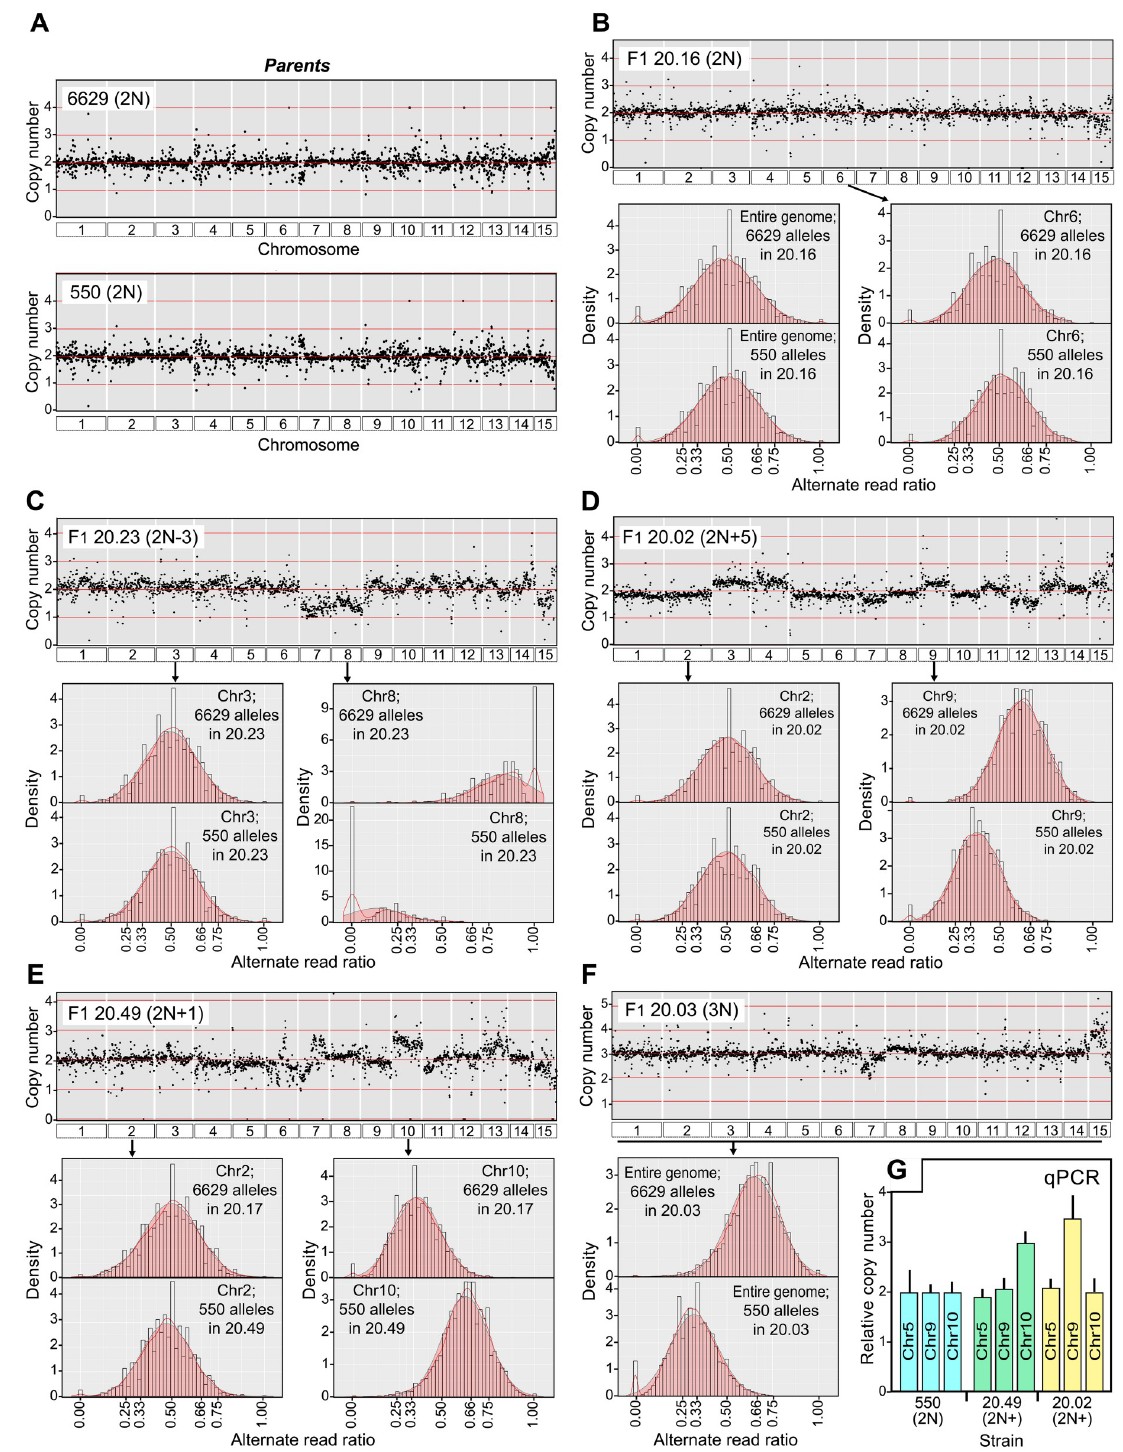
Fig 5. Chromosomal content of representative strains. A , Normalized Illumina read depth across all chromosomes in parents 6629 and 550. B , A representative diploid F1 (20.16) from the 6629 × 550 cross. Plotted in the scatterplot at the top is the normalized read depth. Presented below are bar graphs showing the alternate read ratios (i.e. inferred allele ratios) of SNPs originating from 6629 and 550 across the whole genome (left) or on a representative chromosome, Chr6 (right). C , Data for an aneuploid F 1 , 20.23, which bears Chr7 and 8 deficiencies. Read ratio graphs are shown for a typical 2N chromosome (Chr3) and one with a deficiency (Chr8). D , Similar data for F1